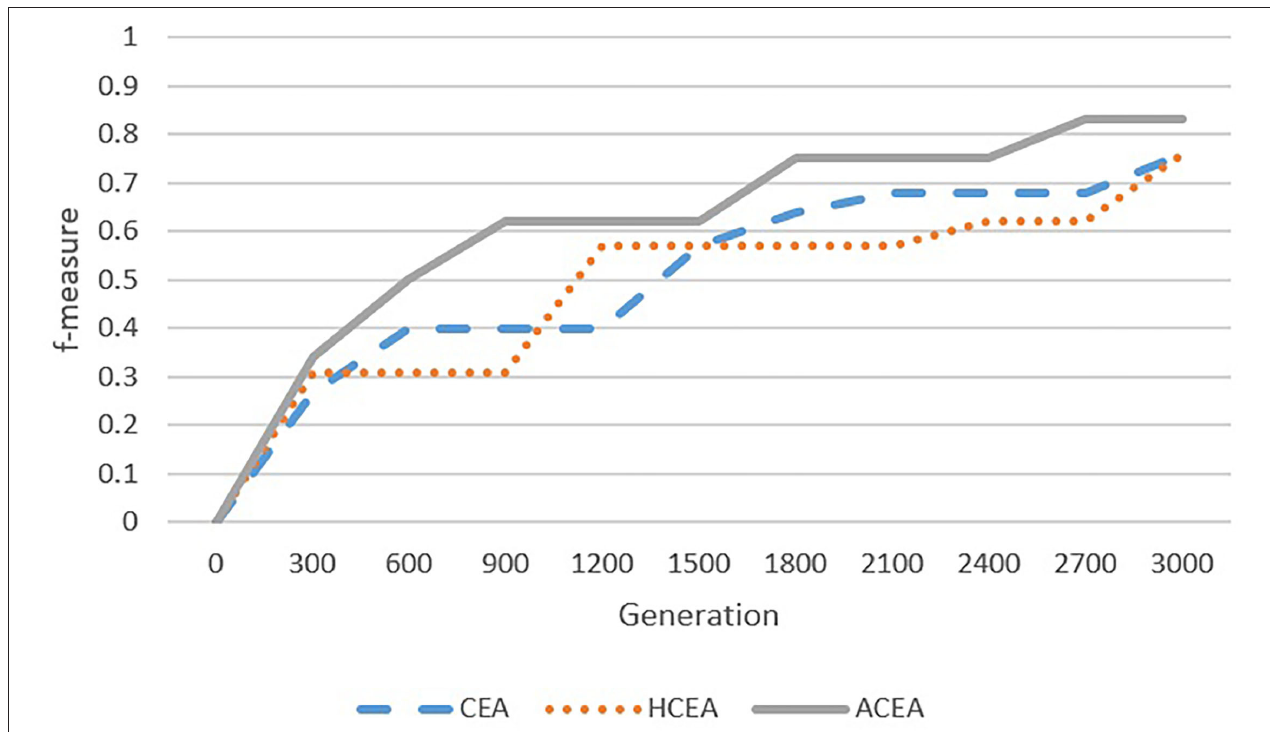
FIGURE 7 | Comparison among ACEA, CEA, and HCEA in terms of convergence graph on